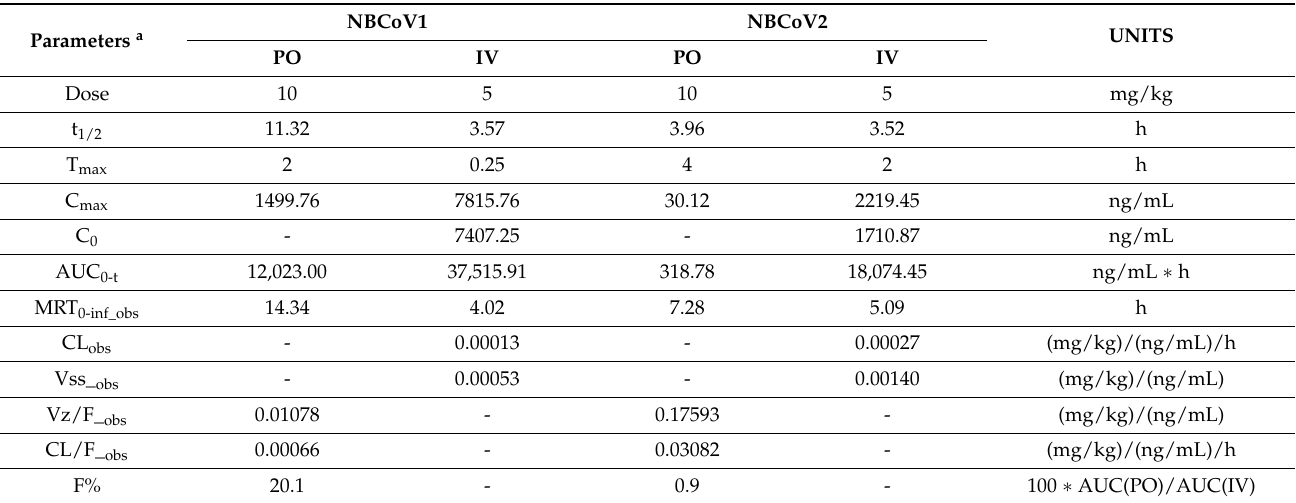
Table 8. In vivo PK parameters in rats of the two most active inhibitors, NBCoV1 and